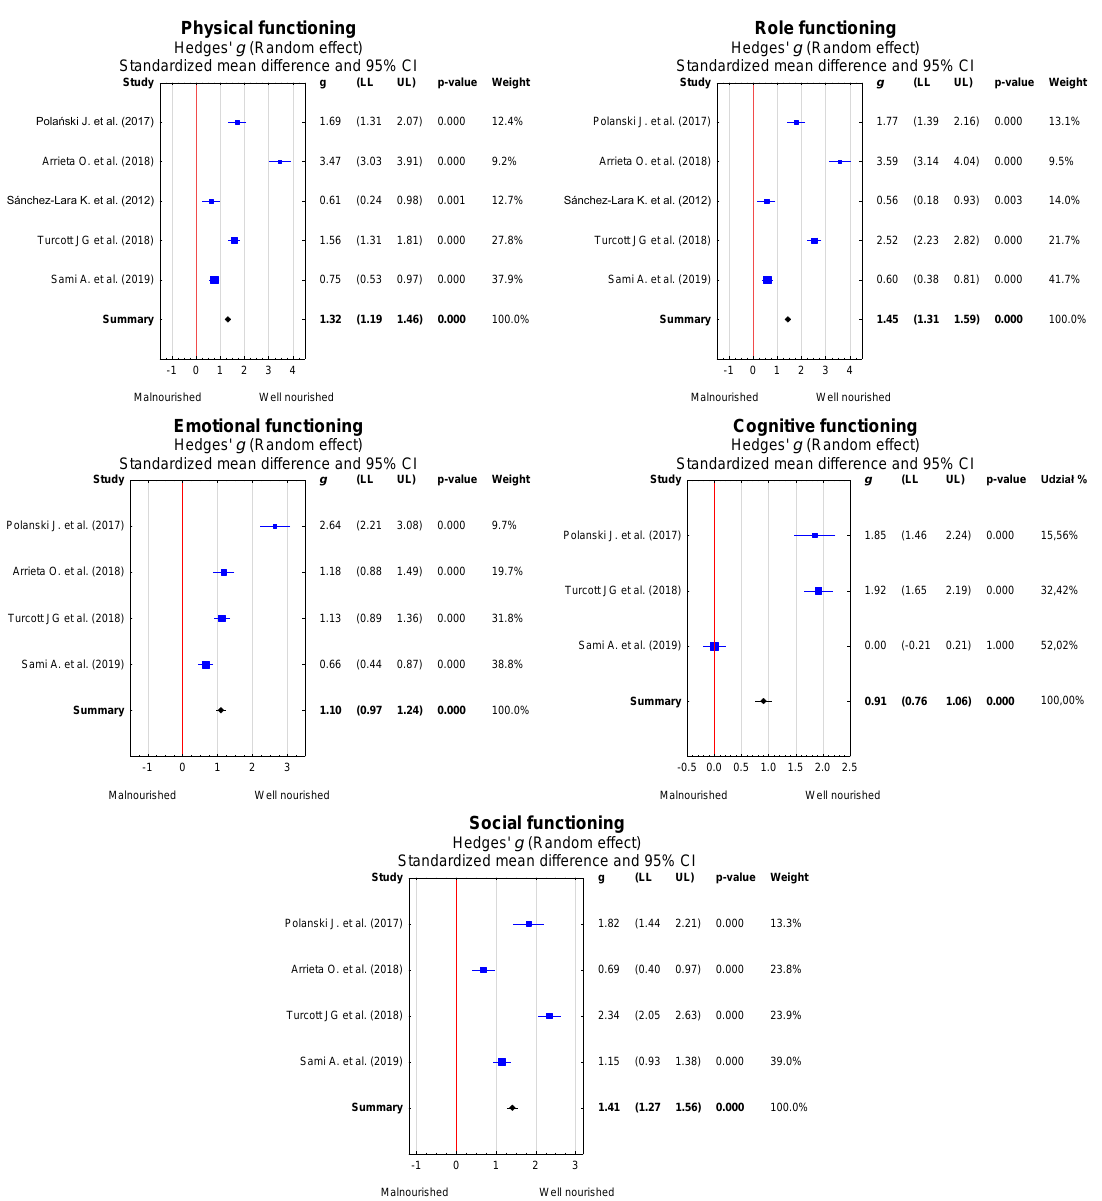
Figure 5. Meta-analysis results for five QoL domains in lung cancer patients broken down by nutritional status.